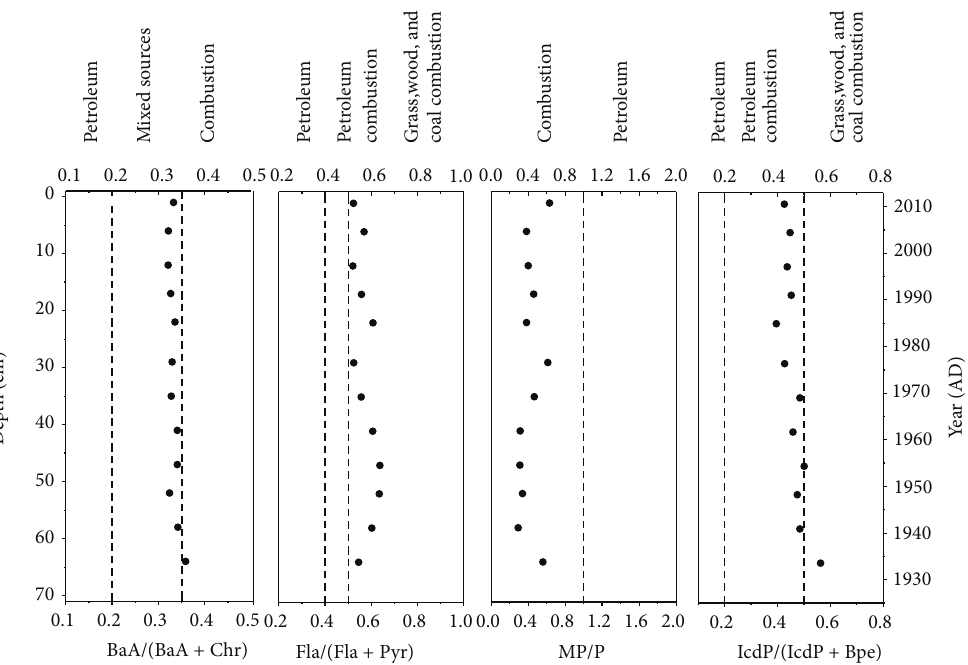
Figure7:HistoricalprofilesofdiagnosticratiosofPAHsinsedimentcorefromsouthernBohaiSea,China.IcdP:indeno[1,2,3-cd]pyrene;Bpe: benzo[g,h,i]perylene; Fla: fluoranthene; Pyr: pyrene; BaA: benz[a]anthracene; Chr: chrysene; MP: methyl phenanthrenes; P: phenanthrenes. The dash lines represent the thresholds for different sources